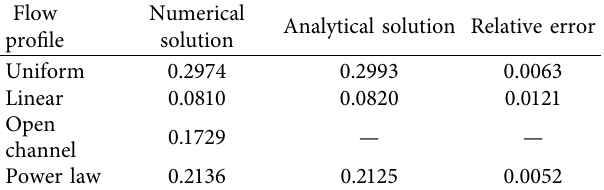
Table 1: The numerical solution, the analytical results, and the relative error of the deflection angle for various flow fields.